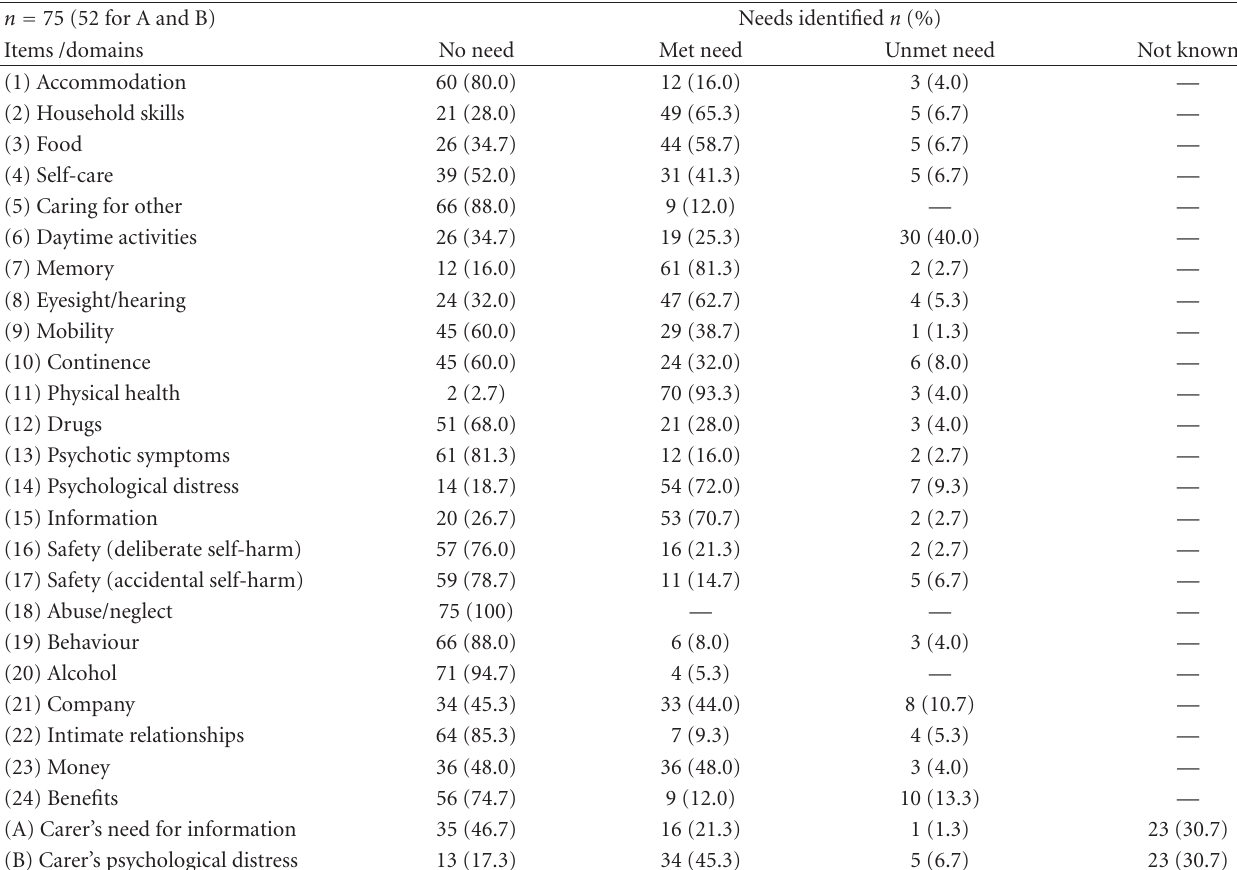
Table 4: Levels of need, as rated by the